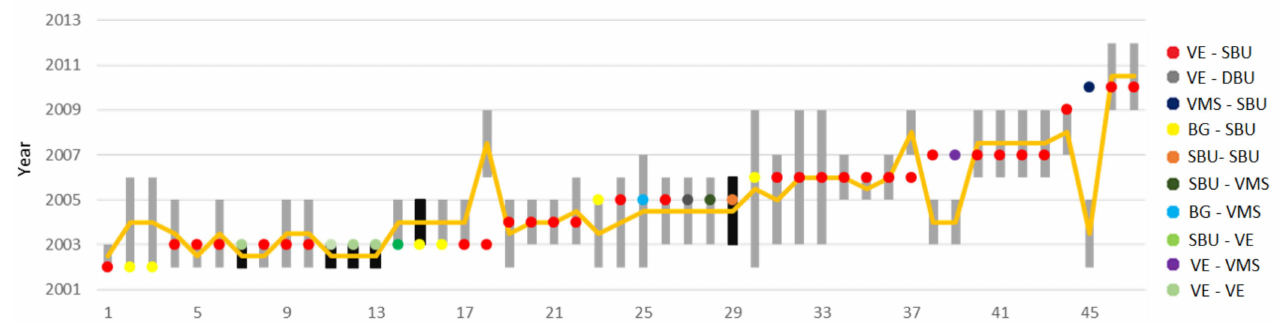
Figure 7. Bars show range of high-resolution images denoting the period of possible change. Grey bars show change , black bars show partial-change . Yellow line denotes the middle period of the high-resolution image range. Abbreviations correspond to Table 2.